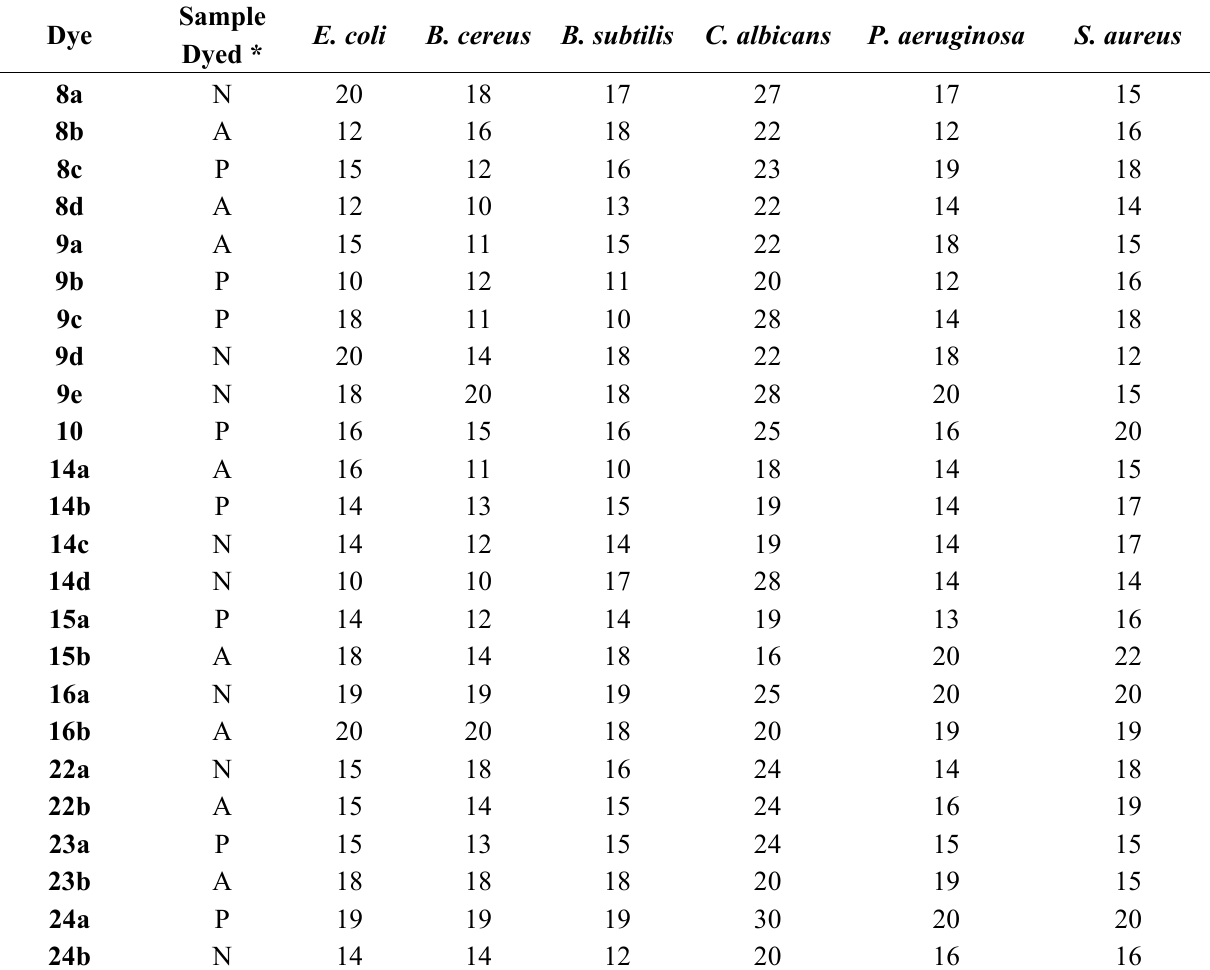
Table 3. Antimicrobial and antifungal potentialities of the tested dyed fabrics express as size (mm) of inhibition